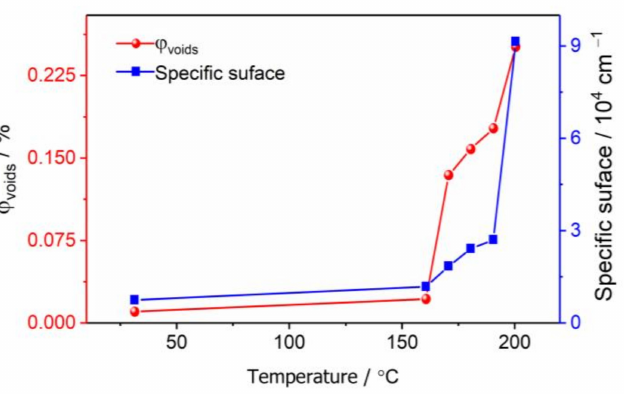
Figure 5. Pore volume fraction and specific surface of CL-20 before and during phase